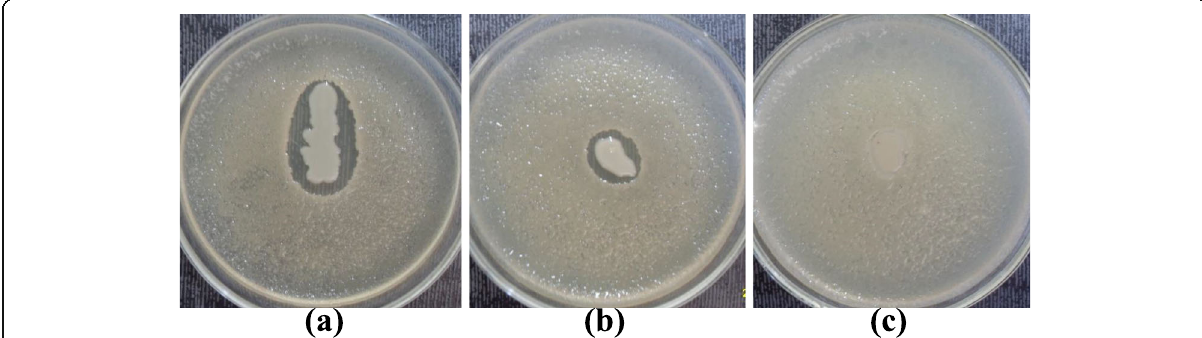
Fig. 2 Antagonistic activity of isolates Amo-23 showing inhibition zones against soft rot bacterial strain Pc B1158 T . a , b are representatives of positive inhibition as shown by the encircled inhibition zones, and c is presenting negative inhibition as demonstrated by the no-inhibition